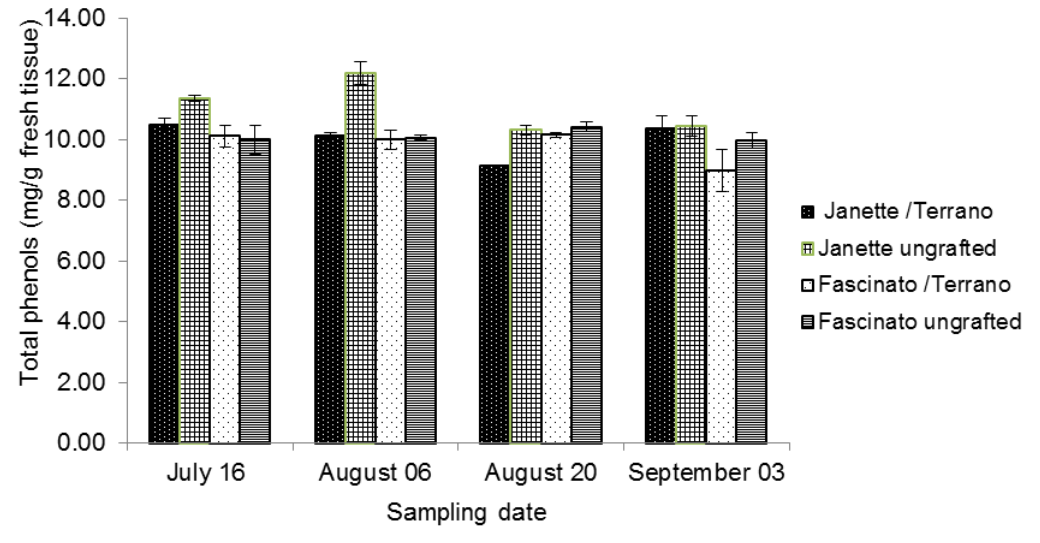
Figure 2. Total phenol concentrations in two bell pepper varieties grafted and